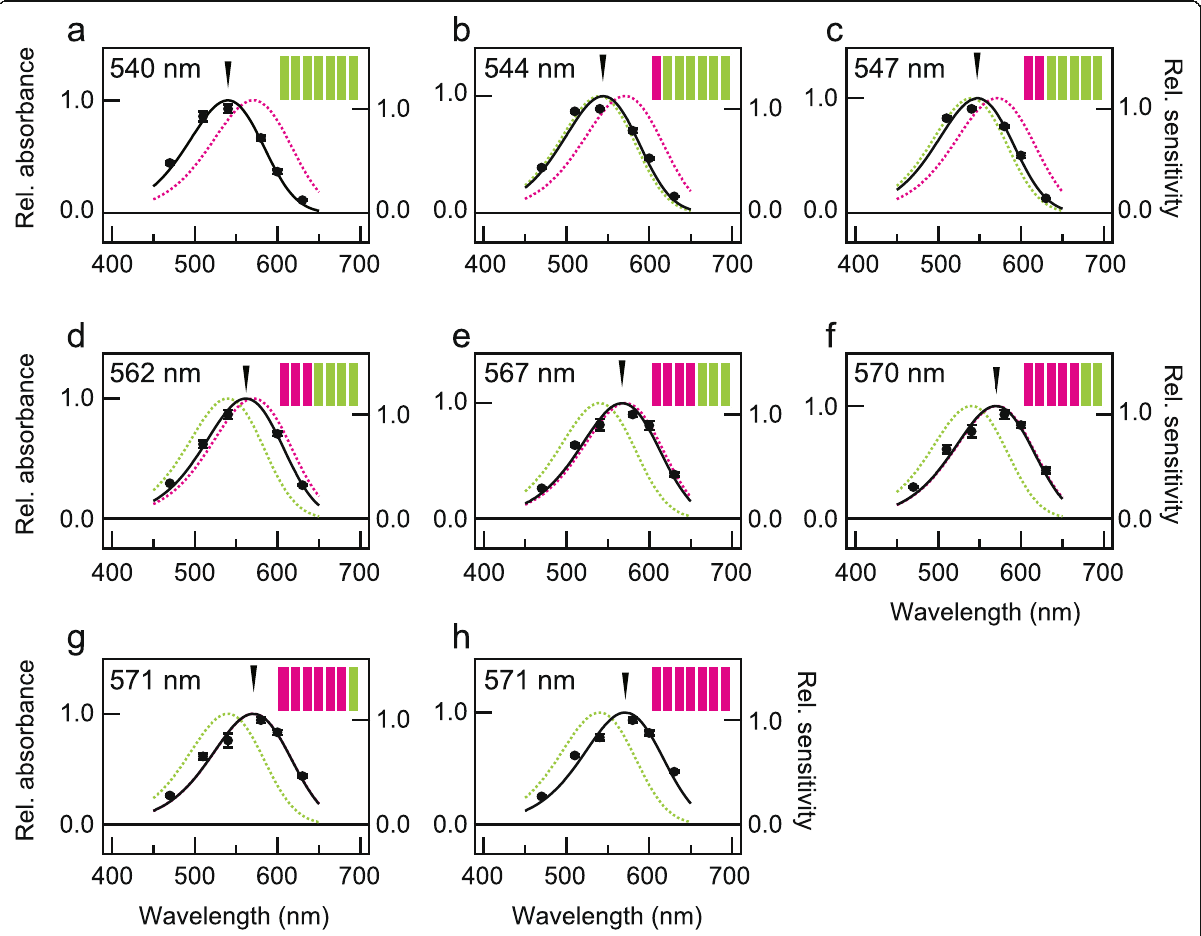
Fig. 2 Estimated absorption spectra of chimeric mutants of PxRh1 and PxRh3. The absorption spectra of WT and chimeric mutants with respect to the transmembrane helix between PxRh1_Gs ( a ) and PxRh3_Gs ( h ), Rh3(I)/Rh1(II-VII) ( b ), Rh3(I,II)/Rh1(III-VII) ( c ), Rh3(I-III)/Rh1(IV-VII) ( d ), Rh3(I-IV)/ Rh1(V-VII) ( e ), Rh3(I-V)/Rh1(VI,VII) ( f ), Rh3(I-VI)/Rh1(VII) ( g ) estimated by heterologous action spectroscopy. Solid circles represent the mean relative sensitivities of cultured cells expressing each of WT or chimeric mutant at each wavelength of light irradiation ( a and h ; n = 9, b-g; n = 3) and black curves indicate estimated absorption spectra. Error bar represents standard errors. The estimated absorption spectra of PxRh1_Gs and PxRh3_Gs are also indicated by green and magenta broken curves, respectively. Schematic drawings of seven transmembrane structures of butterfly opsins are also shown, in which helices of PxRh1 and PxRh3 are indicated by green and magenta,